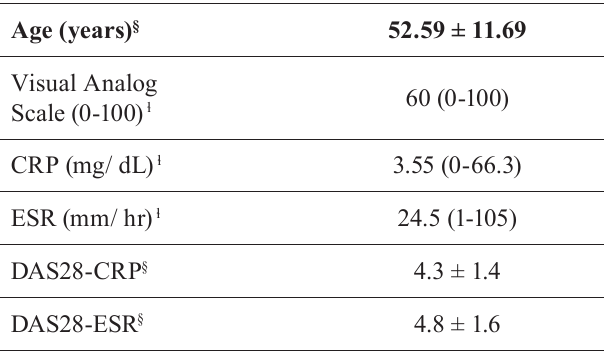
FIGURE 1 - DAS28-ESR (x-axis) scores opposed to DAS28- CRP scores (y-axis). Each point corresponds to a single patient. The diagonal line indicates perfect agreement between the two DAS28 scores.